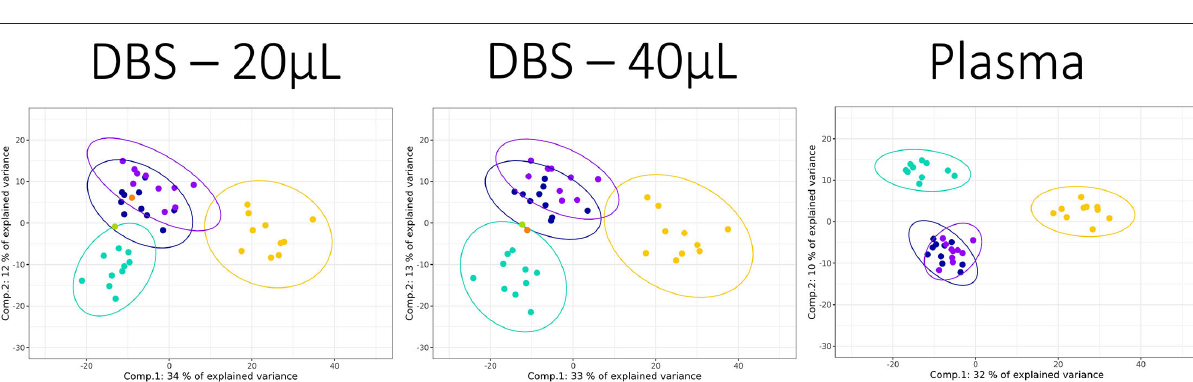
FIGURE 2 | PLS-DAscores plots for dog breed data collected for three sample types applying the HILIC positive ion mode assay. The sample classes were Norfolk terrier: yellow, Labrador retriever: turquoise, Beagle: dark blue, and Petit Basset Griffon Vendeen: purple. The two blinded DBS samples, blind sample 1: orange and blind sample 2: green, were overlaid on the relevant DBS plots. The 95% confidence ellipses were plotted for each breed class. Components 1 and 2 variances were 34 and 12% (DBS 20 µ L), 33 and 13% (DBS 40 µ L), and 32 and 10%